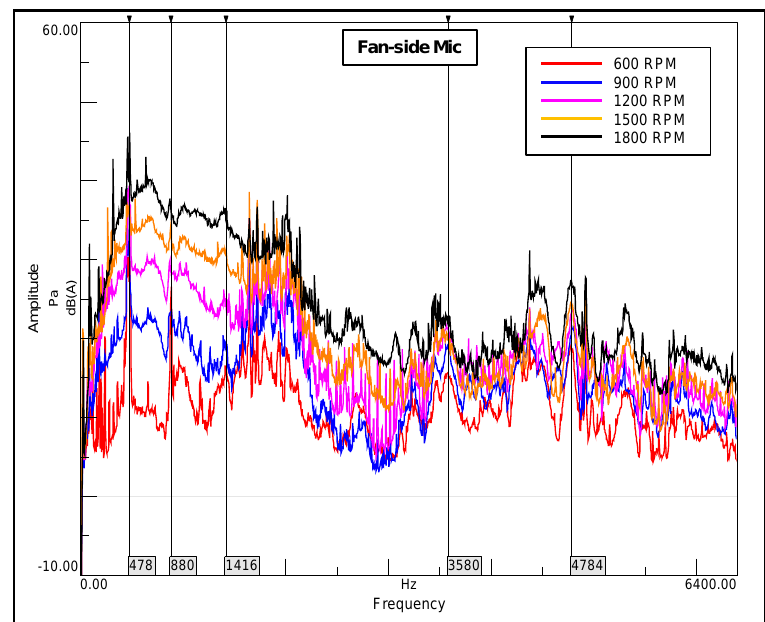
Figure 11. Acoustic auto-power spectrum from fan side microphone with RMS dB(A) values at 600, 900, 1200, 1500, and 1800 RPM .